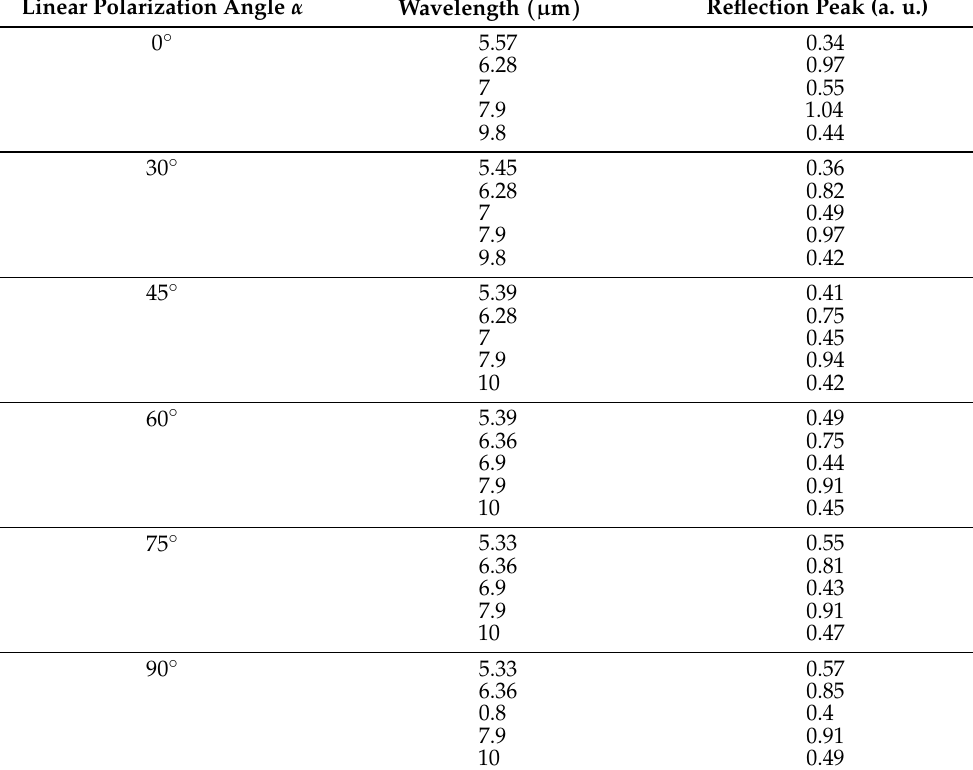
Table 4. Peak values associated with the reflection spectrum of structure 3C, at linear polarization angles α = 0 ◦ , α = 30 ◦ , α = 45 ◦ , α = 60 ◦ , α = 75 ◦ and α = 90 ◦ . These frequencies correspond to frequencies of minimal